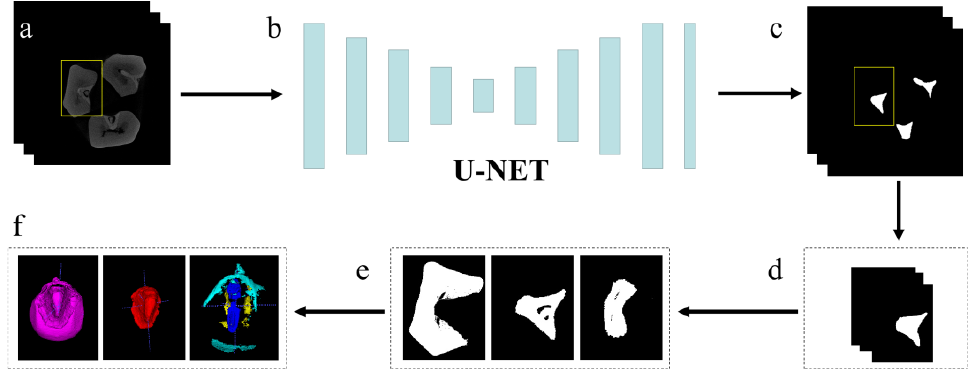
Figure 1. The flow chart of batch kernel treatment pipeline. Note: ( a ) CT image sequence. ( b ) U-Net network. ( c ) Segment embryo and kernel masks. ( d ) Extract a single kernel with an embryo. ( e ) Generate endosperm, embryo, and silty endosperm with cavities. ( f ) Visualize the 3D structures of endosperm, embryos, and cavities. Yellow box represents a single kernel that is automatically extracted for phenotyping and visualization.